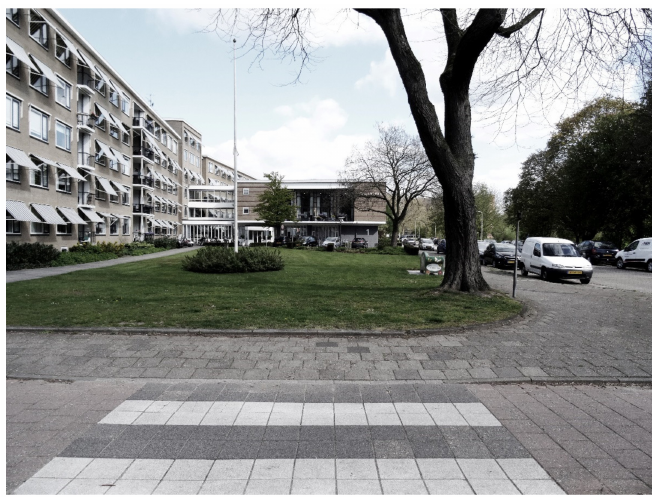
Figure 3 View of the main entrance of Humanitas, c (cid:13) Davide